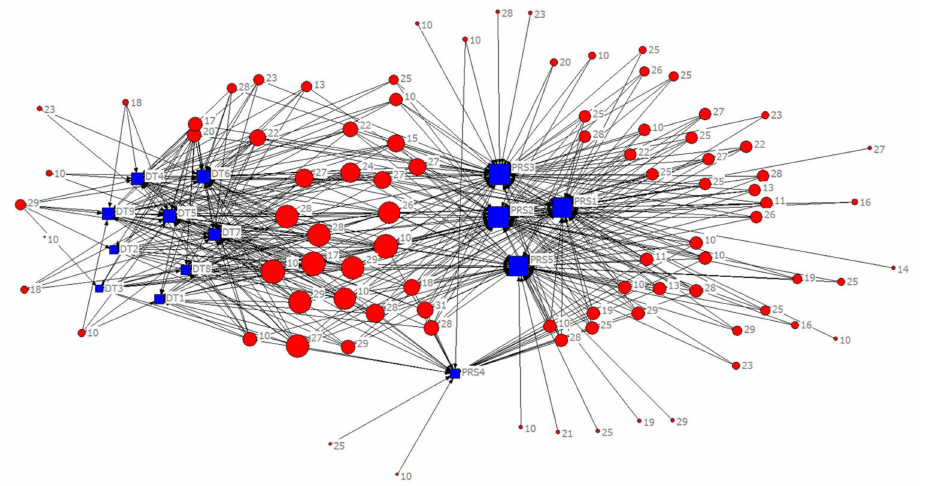
Figure 2. The network of manufacturing firms from